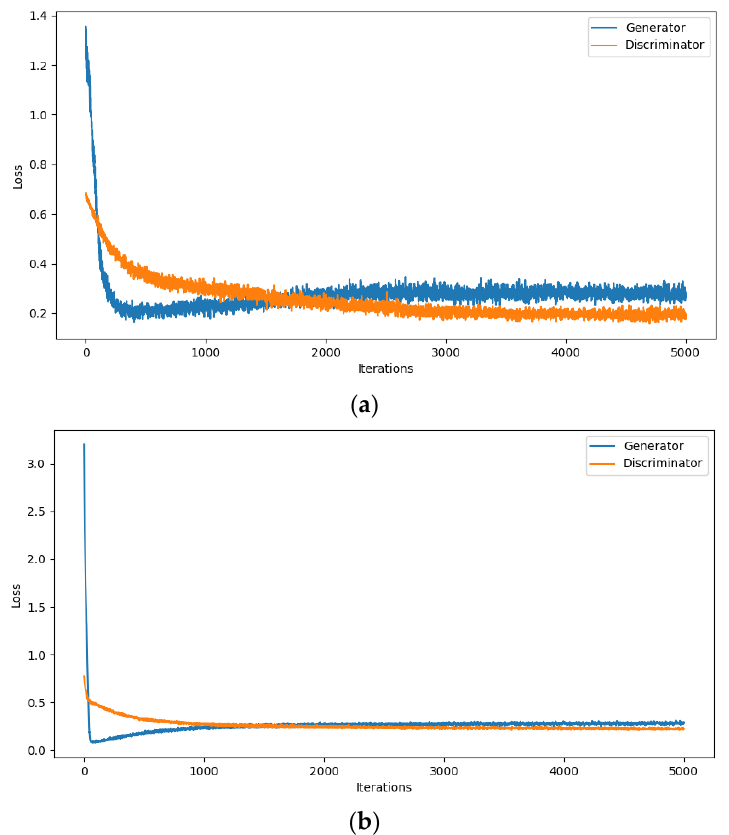
Figure 8. The iteration loss of the generator D and discriminator G: ( a ) GAIN, and ( b ) WFGAIN- GP.